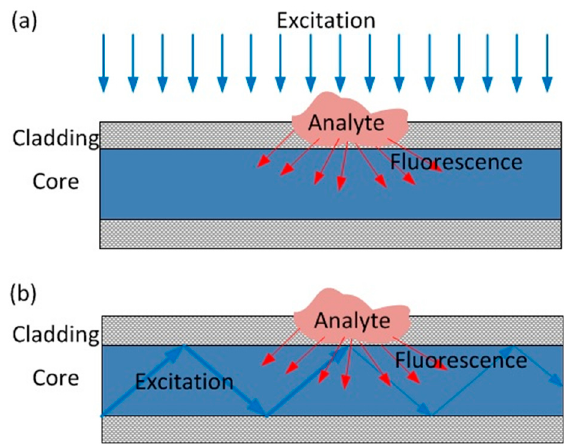
Figure 12. ( a ) First generation of fluorescence-based distributed chemical sensing (DCS), where the dopant is excited by side illumination. ( b ) Modified fluorescence-based DCS, where the dopant is excited by an evanescent field of the light propagating inside the core. The shaded region represents cladding immobilised with fluorophore. The weight of the line represents the optical power.